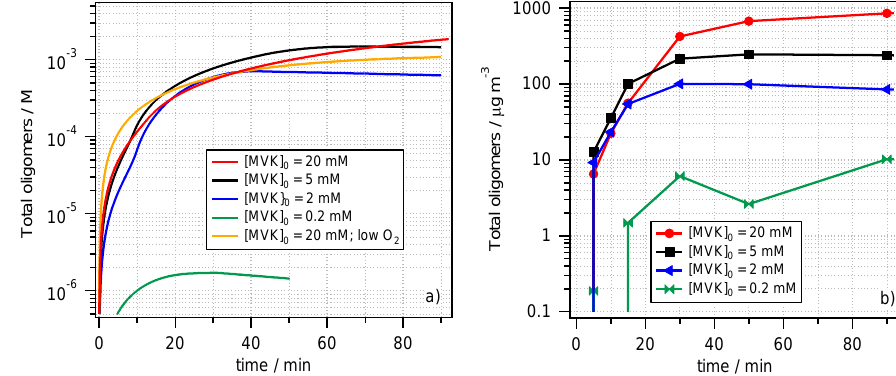
Figure 4. (a) Predicted oligomer concentrations (sum of all seven oligomer series in Fig. 1) for different initial MVK concentrations (constant [MVK] 0 / [H 2 O 2 ] 0 ) . (b) Total oligomer mass, determined by SMPS measurements from the nebulized solutions (cf. Fig. 7 by Renard et al., 2015, Part